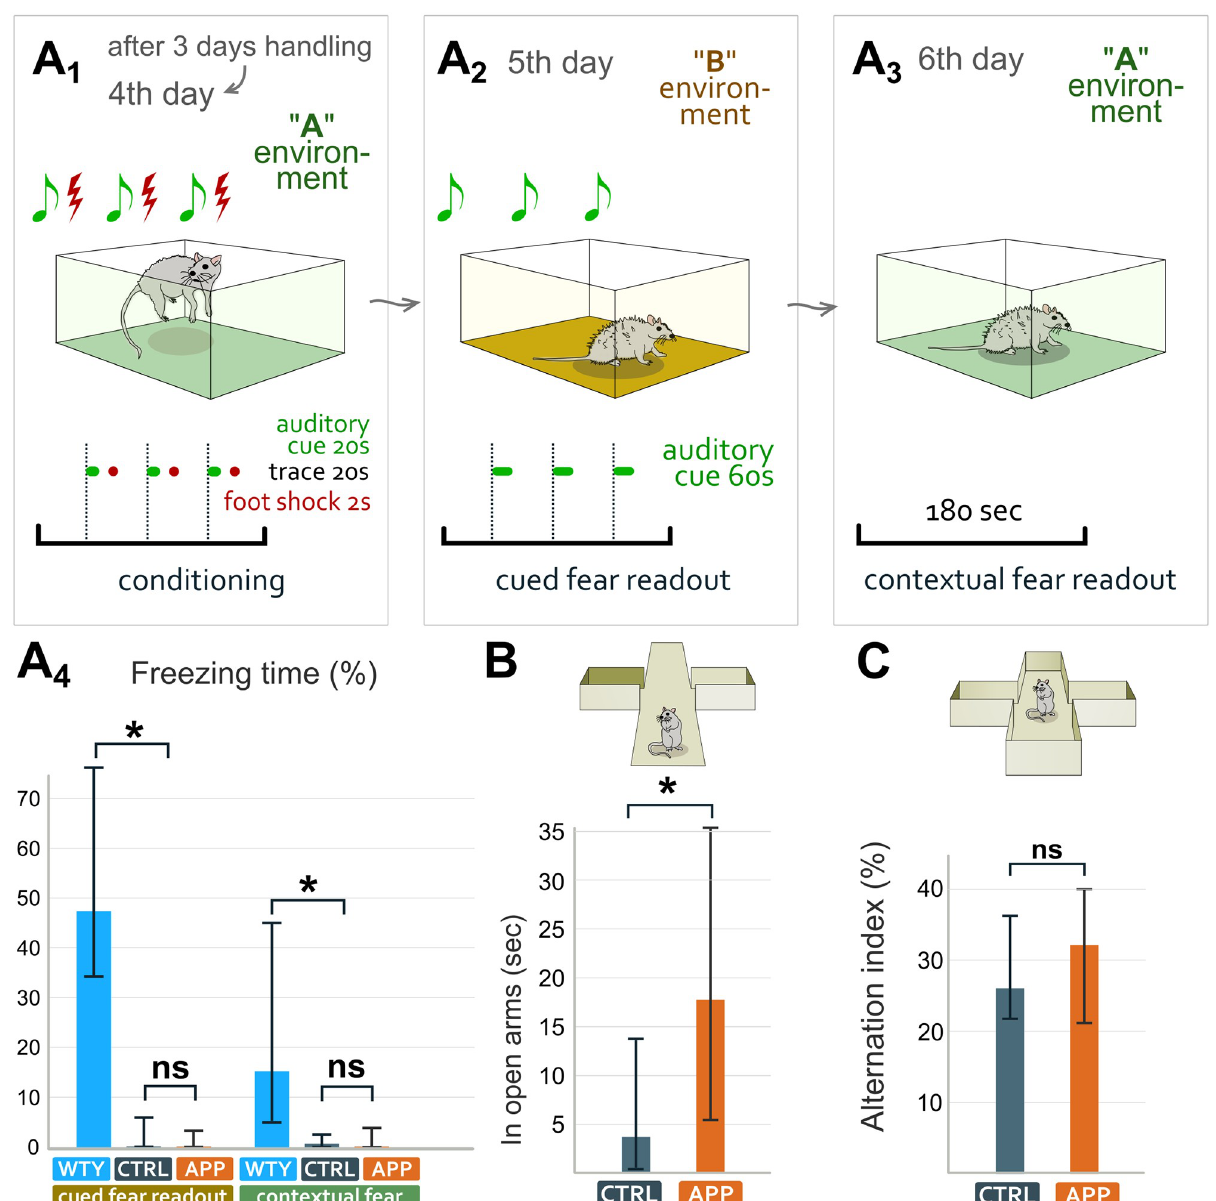
Fig 7. Behavioral examination of APP NL-F mice. A: Contextual and cued fear memory of APP NL-F mice was tested in the trace fear conditioning paradigm, where the neutral tone and the aversive shocks were separated by a 20 sec trace interval (A1), that was followed by testing cued fear (A2) and contextual fear memory (A3) on the subsequent 2 days. 15-19-month-old APP NL-F and littermate WT (CTRL) mice both showed impaired fear learning with very low amount of freezing behavior compared to 3-month-old young wild type (WTY) mice (A4). B: 15-19-month-old APP NL-F mice spent significantly more time in open arms than WT (CTRL) littermates during the elevated plus maze paradigm. C: In the spontaneous alternation paradigm 15-19-month-old APP NL-F and littermate WT (CTRL) mice performed similar amount of perfect alternations of ABCD type.